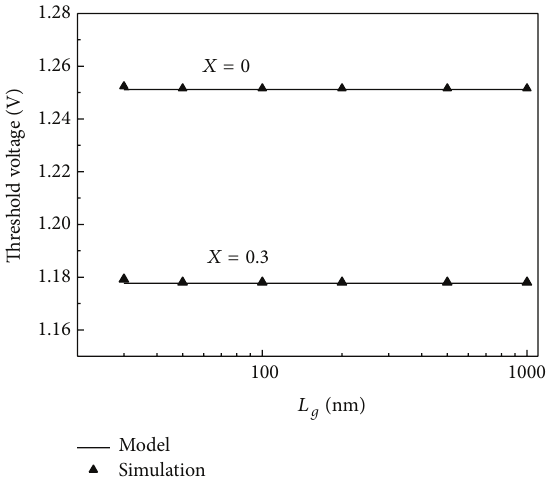
Figure 7: Threshold voltage versus gate length 𝐿 𝑔 . 𝜀 ox = 29 , 𝑡 ox = = 10 nm, and 𝑉 = 1 V. 3 nm, 𝑡 SSi 𝑑𝑠